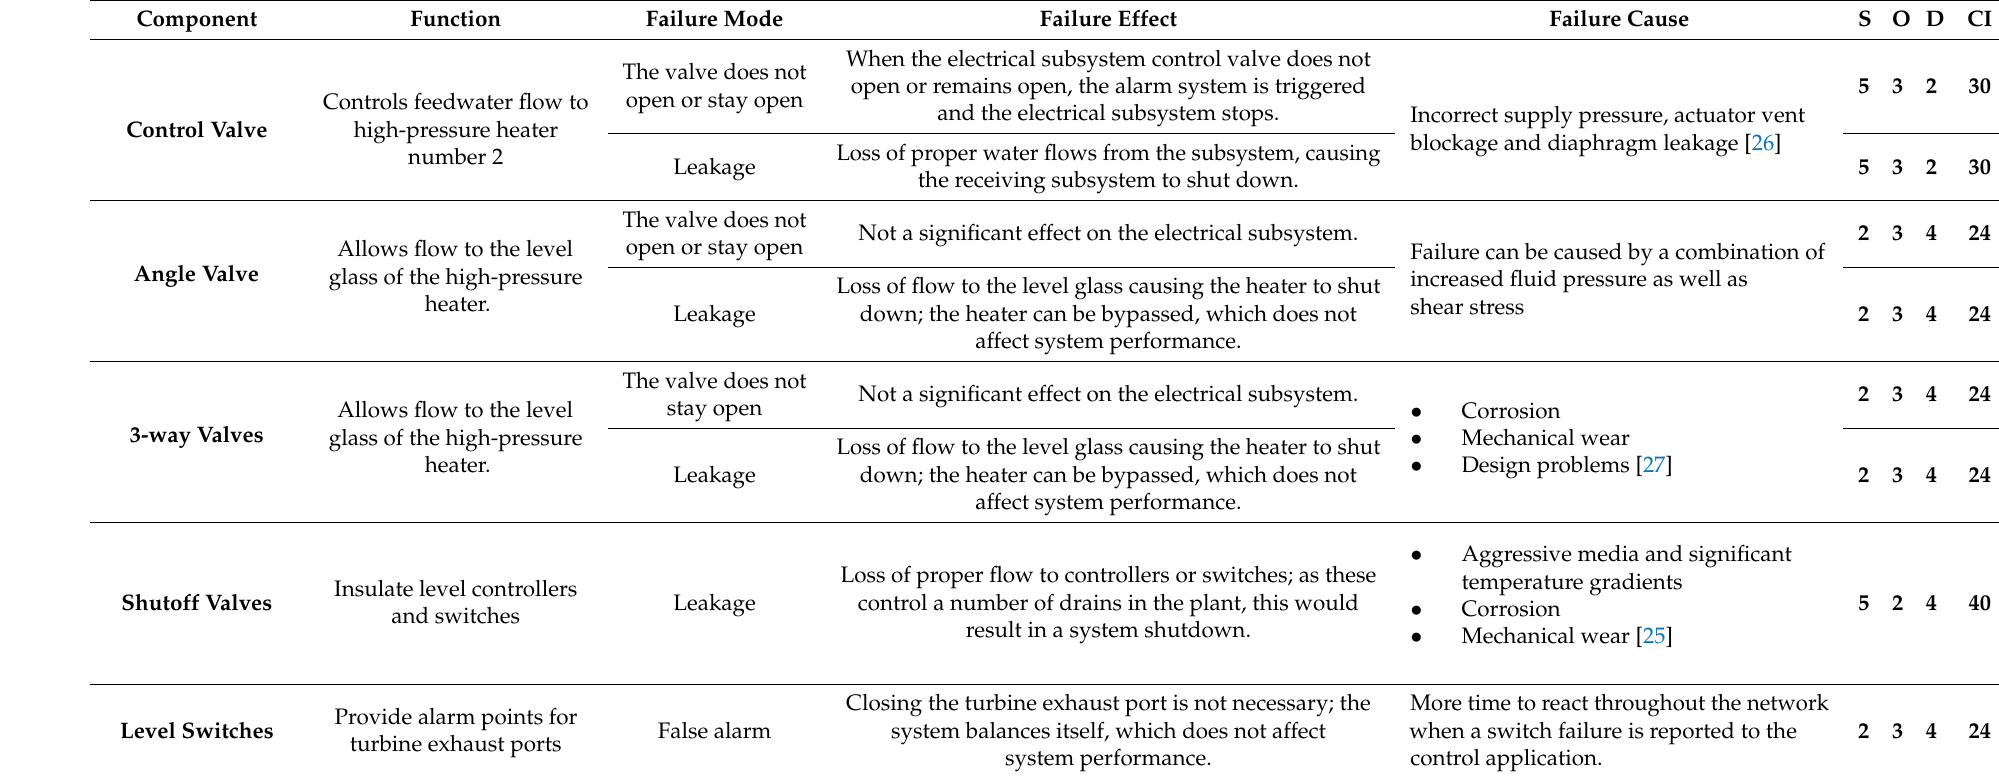
Table 4. Electrical Subsystem